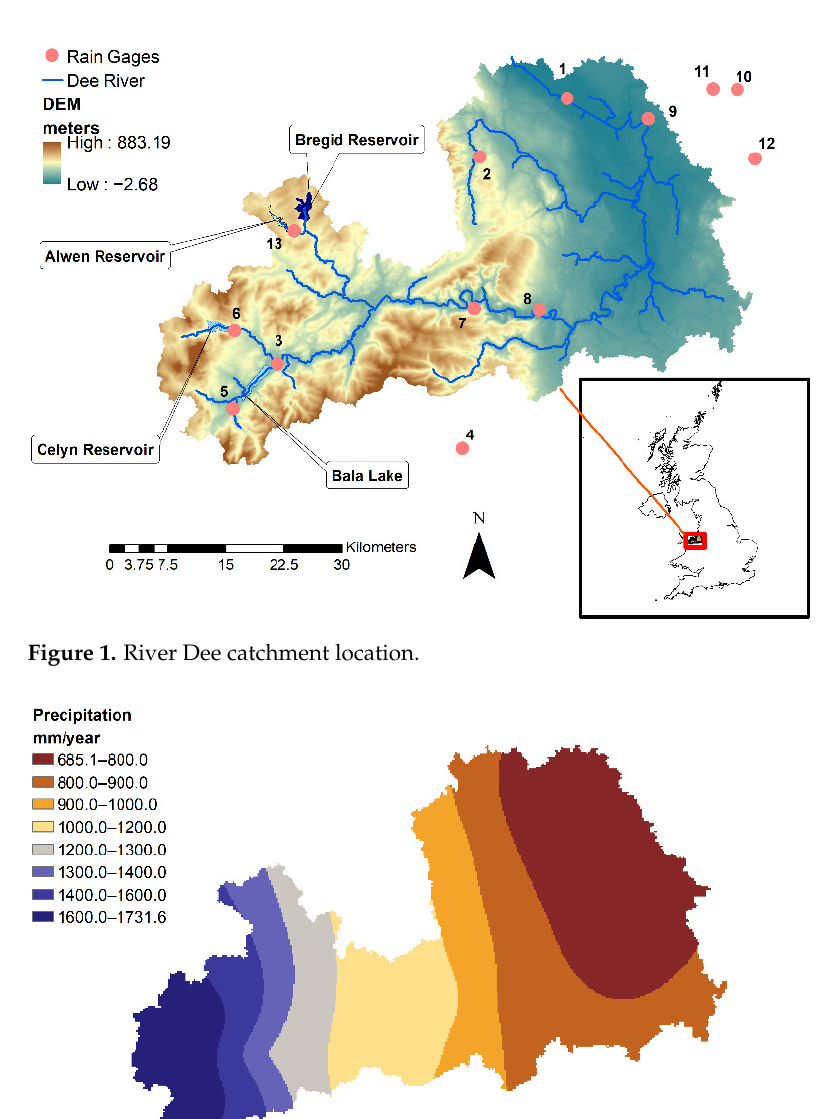
Figure 2. Average annual precipitation in the Dee River basin.